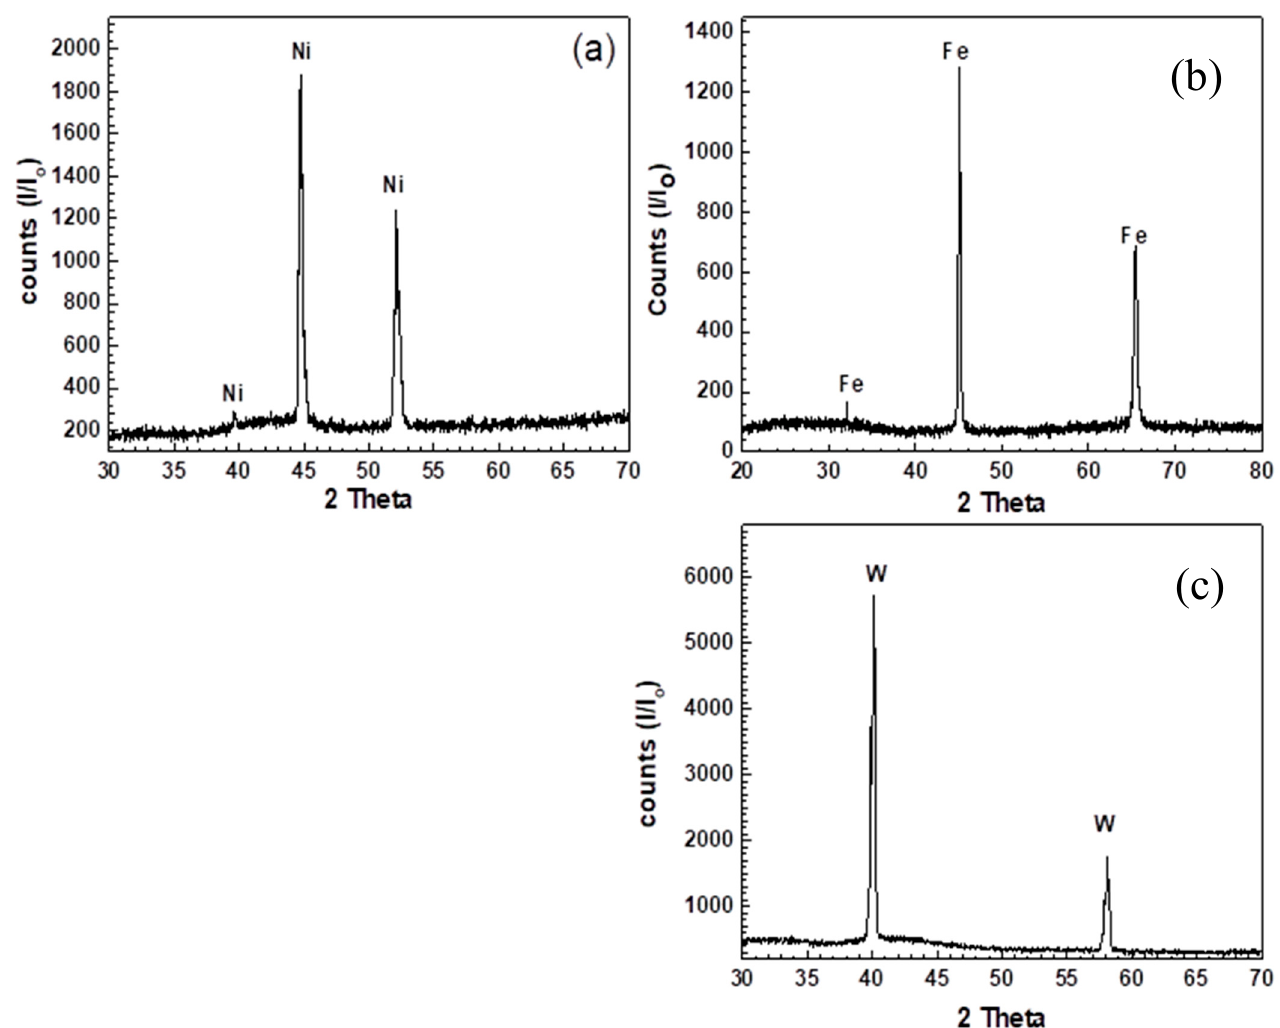
Figure 6. XRD phase analysis of nanosized metal oxides reduced with H 2 at 1000 ◦ C: ( a ) NiO; ( b ) Fe 2 O 3 ; ( c ) WO 3 .